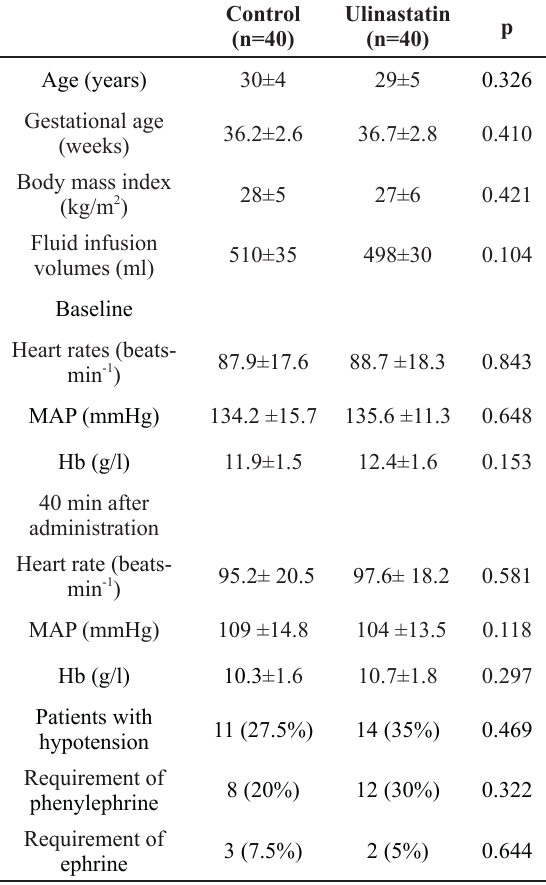
General patient